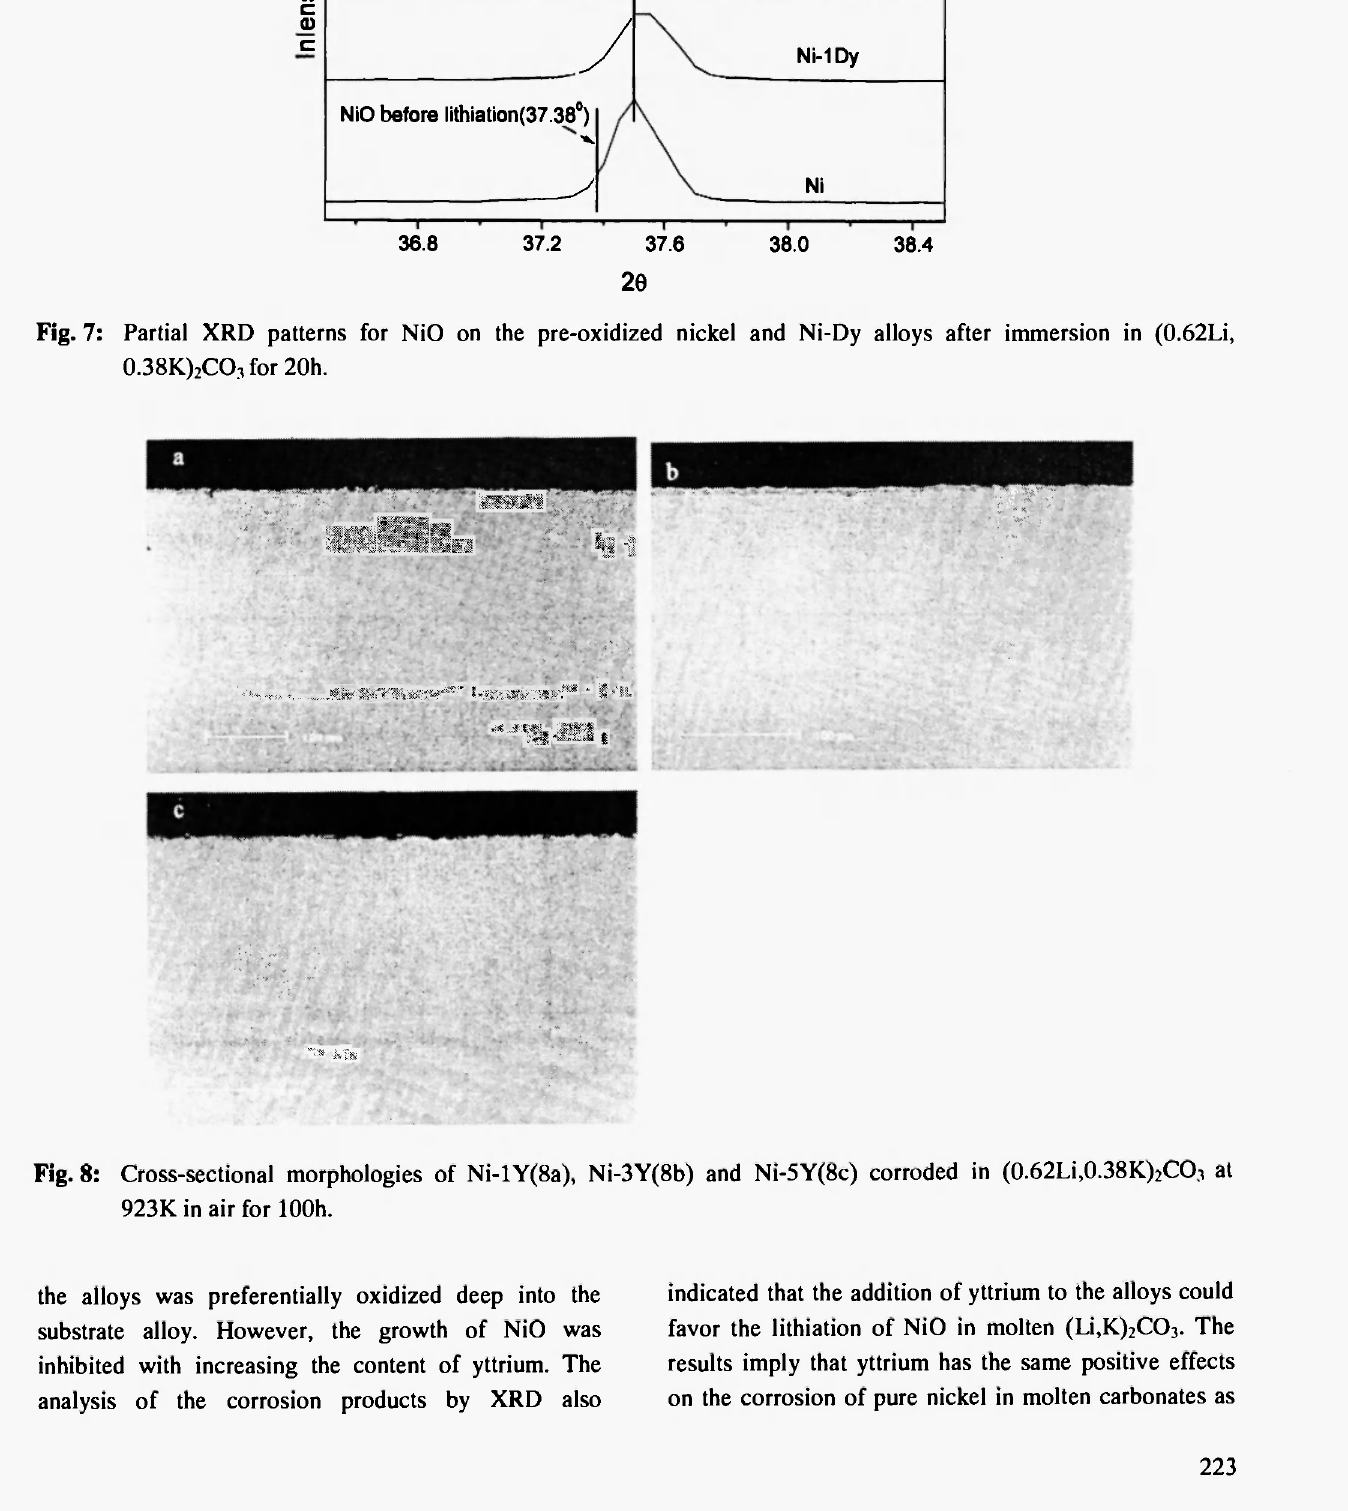
Fig. 8: Cross-sectional morphologies of Ni-lY(8a), Ni-3Y(8b) and Ni-5Y(8c) corroded in (0.62Li,0.38K) 2 C0 3 at 923Κ in air for